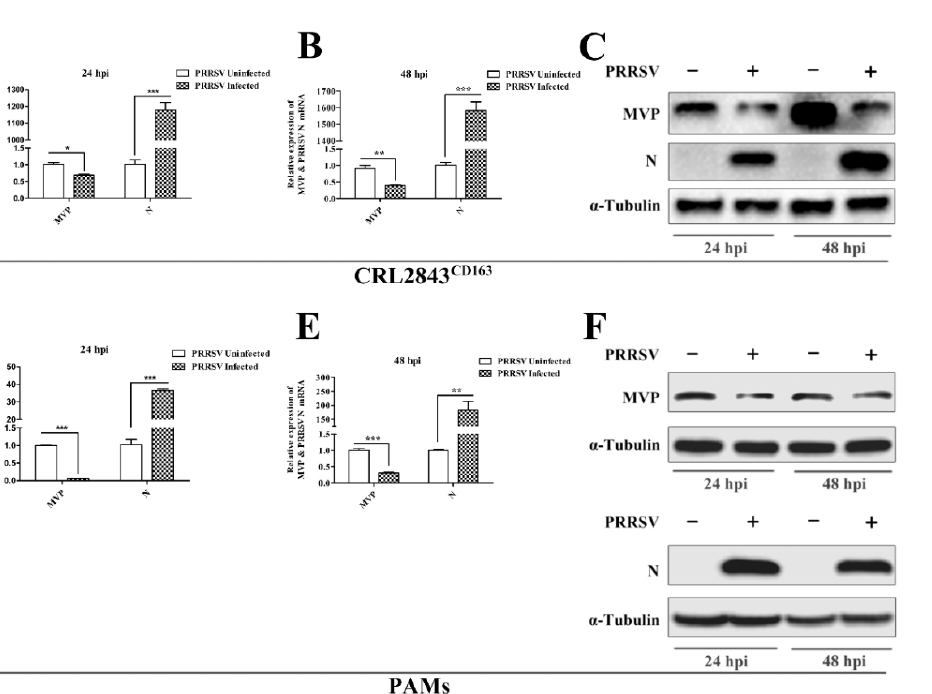
Figure 1. MVP expression was inhibited by PRRSV infection in CRL2843 CD163 cells and PAMs. CRL2843 CD163 cells or PAMs were infected with GD-HD PRRSV at an MOI of 10 or 1 for 24 h and 48 h. The mRNA and protein expression levels of MVP and PRRSV N were detected by qPCR ( A , B , D , E ) and Western blot ( C , F ), respectively. GAPDH and α -tubulin were used as internal loading controls in qPCR and Western blot analyses, respectively. Data from three independent experiments are expressed as the means ± SD. Analysis of differences between the means was performed using Student’s t -test and is marked by * ( p < 0.05), ** ( p < 0.01) and *** ( p <